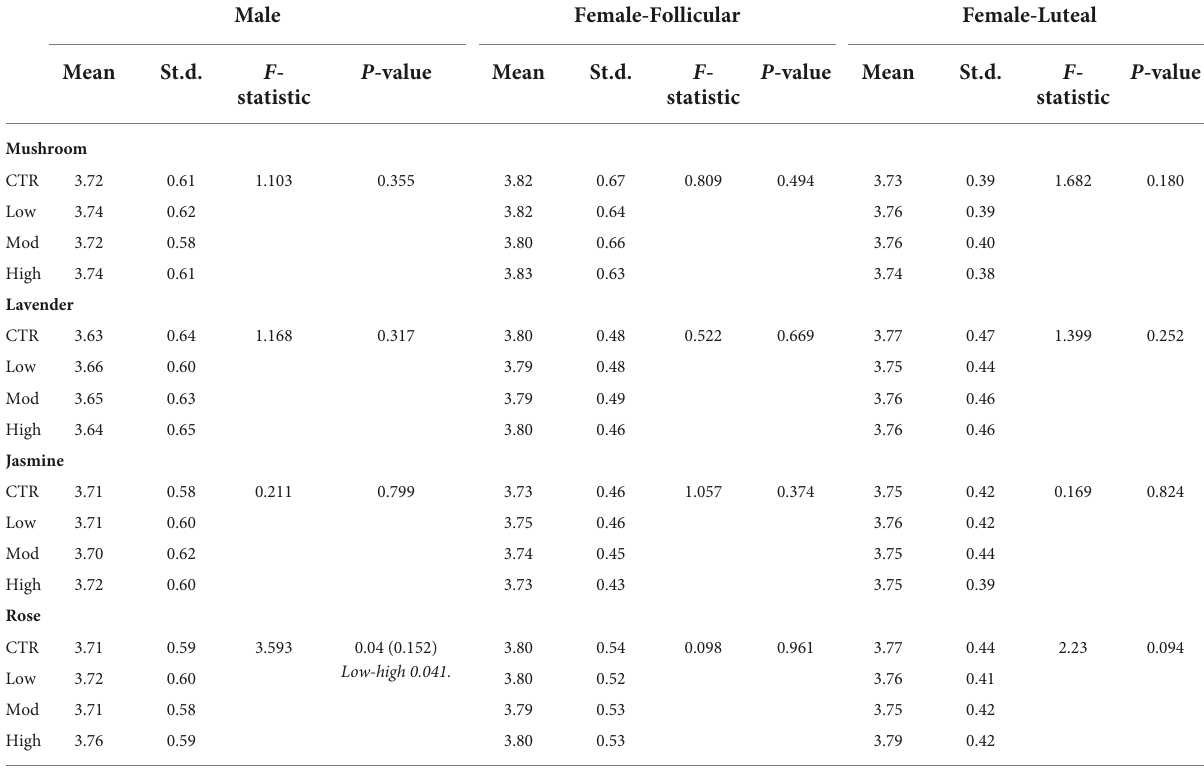
TABLE 2 Repeated-measures ANOVA results from the inter-stimulus washout period comparison for the eye-tracker (the pupil diameter) in the male and female (follicular and luteal menstrual stages)